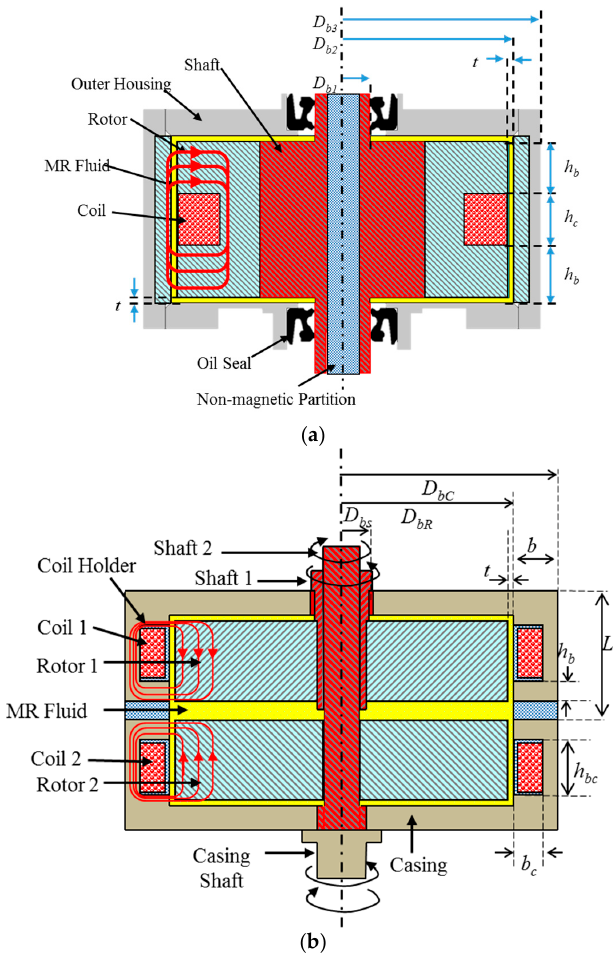
Figure 11. Internal configuration of MR devices; ( a ) MR brake; ( b ) MR clutch.